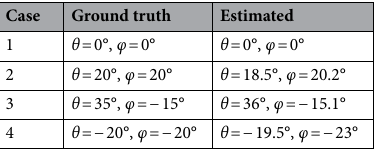
Table 1. Estimated DoA values in comparison to the ground truth at SNR = 20 dB.